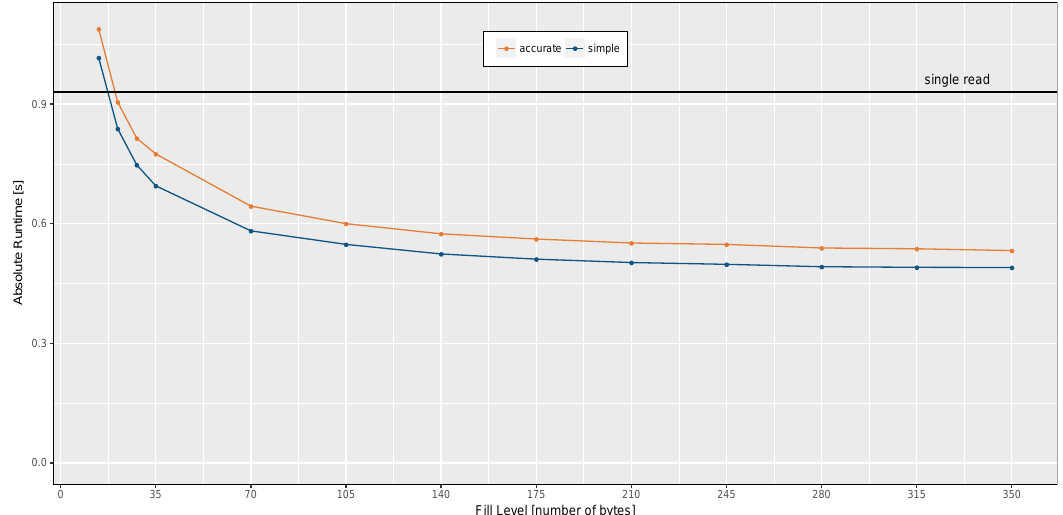
Figure 9. Absolute run-time measurements of both algorithms using different fill levels in comparison with single sample readout, represented by the black